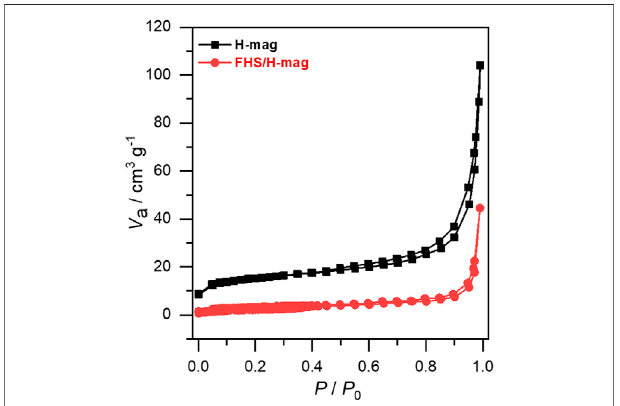
FIGURE 3 | N 2 adsorption/desorption isotherms of H-mag and FHS/ H-mag.